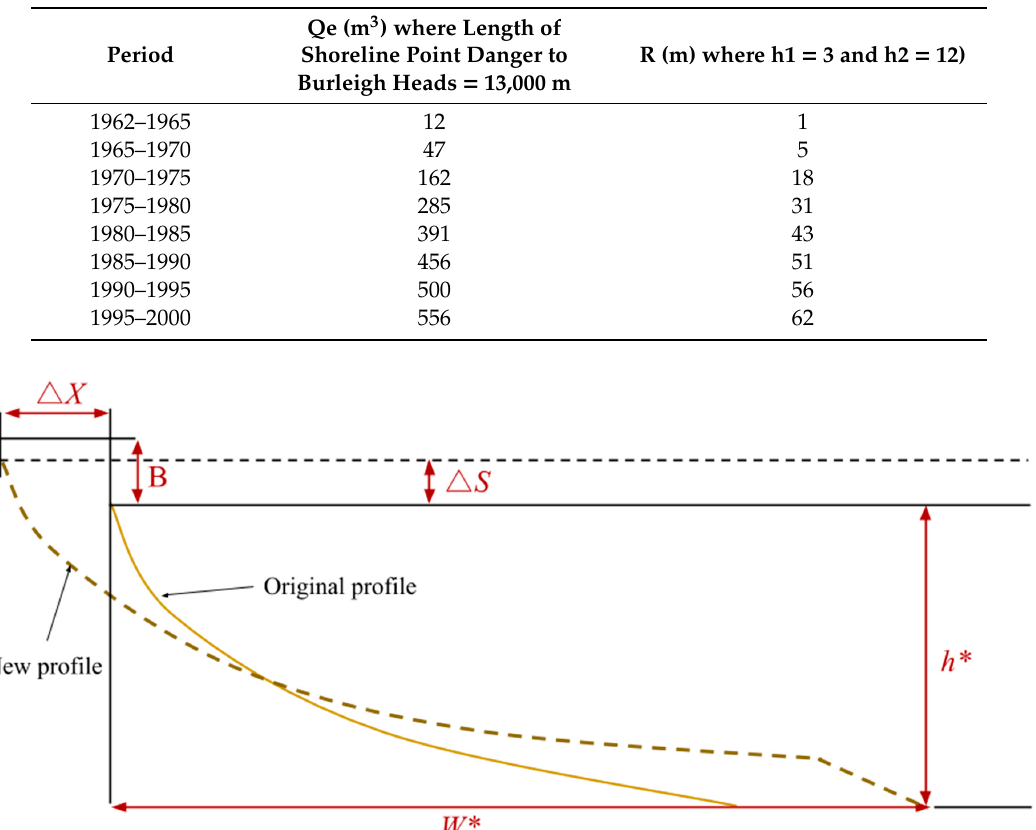
Table 3. Recession of southern Gold Coast beaches due to sand trapped by extended Tweed River training walls between 1960 and 2000.